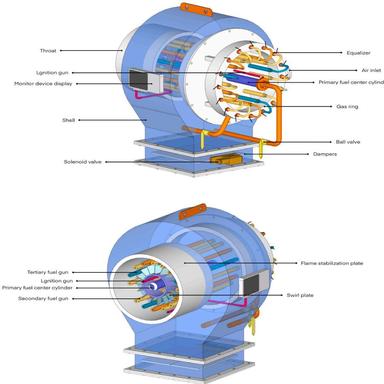
Structure diagram of the burner.